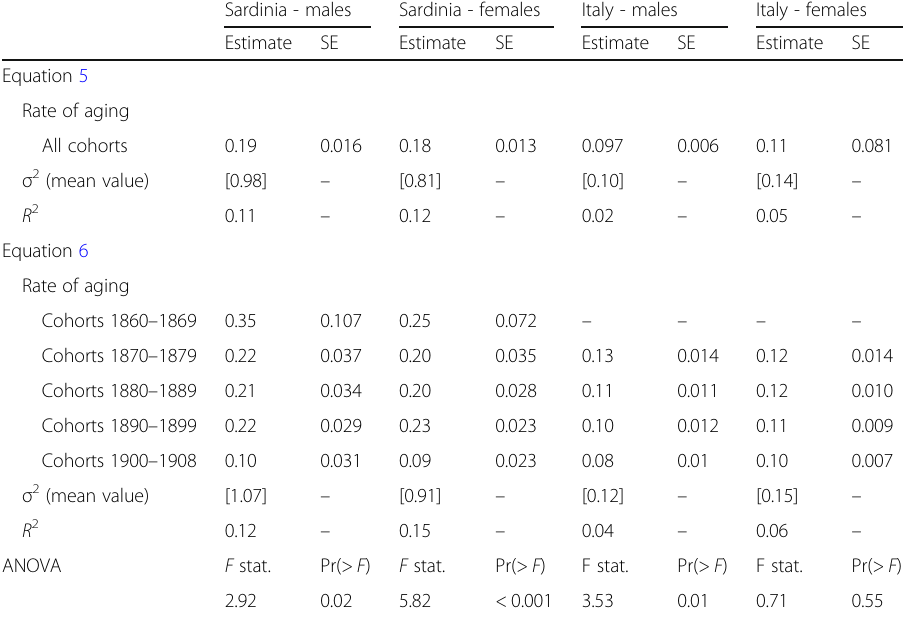
Table 2 Testing the constant senescence hypothesis Sardinia - males Sardinia - females Italy - males Italy - females Estimate SE Estimate SE Estimate SE